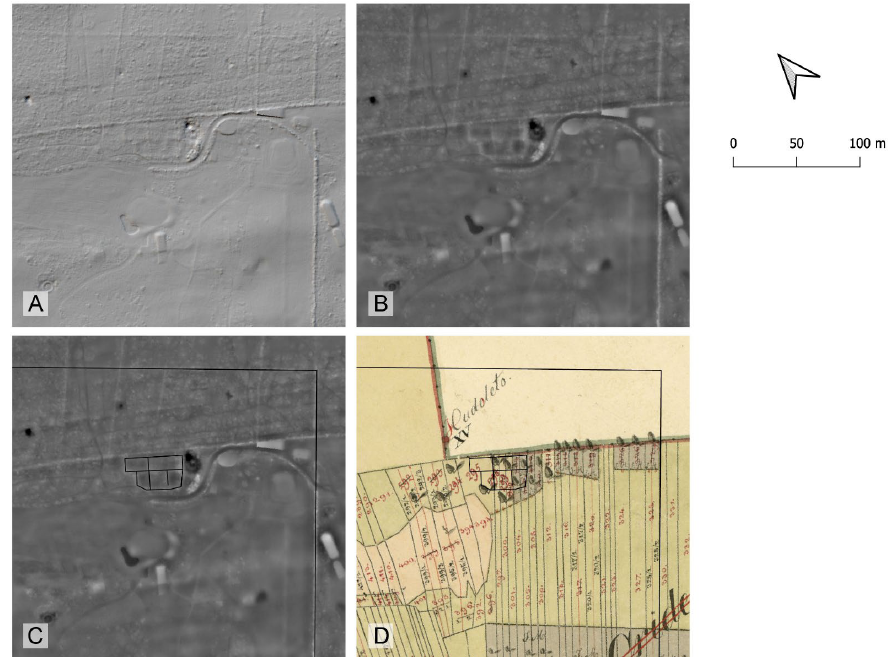
Figure 20. Zoomed view of the rural complex of area L: hill-shaded image ( A ), local relief model ( B ), interpreted local relief model ( C ) and digitized features superimposed onto a 19th century cadastral map ( D ).